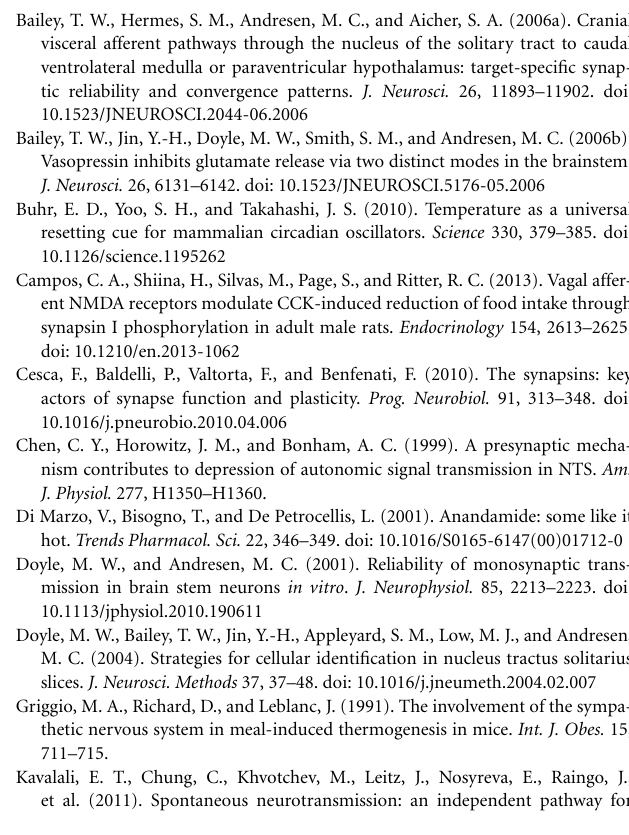
FIGURE 8 | Functional evidence suggesting alternative thermo-TRP channels present in vagal afferents. (A, upper panel) Representative calcium trace from cultured vagal afferent cell bodies showing menthol fails to activate at concentrations selective for TRPM8, but produce large calcium transients at concentrations known to activate TRPV3. (A , lower panel ) Average concentration response relationship for menthol induced increases in cytosolic calcium ( N = 7, P < 0 . 001, ANOVA). Menthol induced calcium increases were significantly reduced with RuR ( N = 9, P < 0 . 001, paired t -test) also consistent with TRPV3 activation. (B , upper panel ) Calcium trace showing the concentration-dependent increase in cytosolic calcium by the TRPV3 agonist ethyl vanillin in cultured